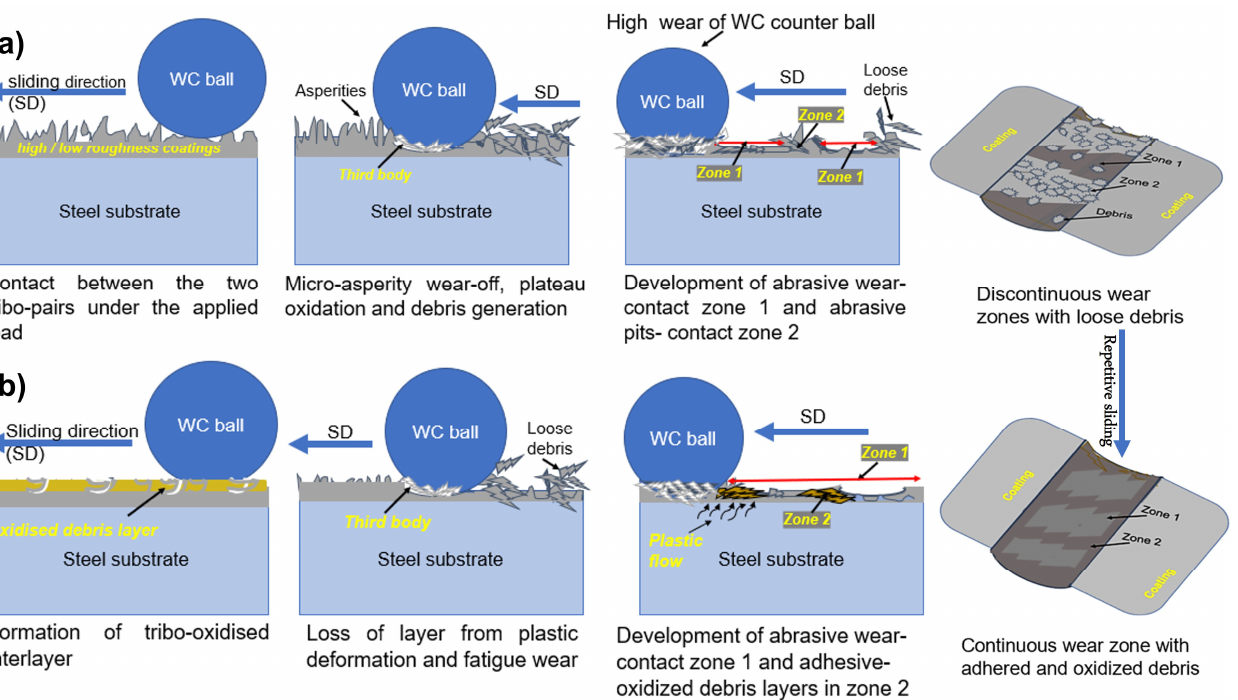
Figure 15. A schematic of the wear evolution proposed for the produced HEACs: ( a ) abrasive wear mode with plastic deformation and debris generation at the onset of sliding and ( b ) third body influence with subsequent decrease in the wear. Wear transition from mode ( a ) to ( b ) due to oxidation and repetitive